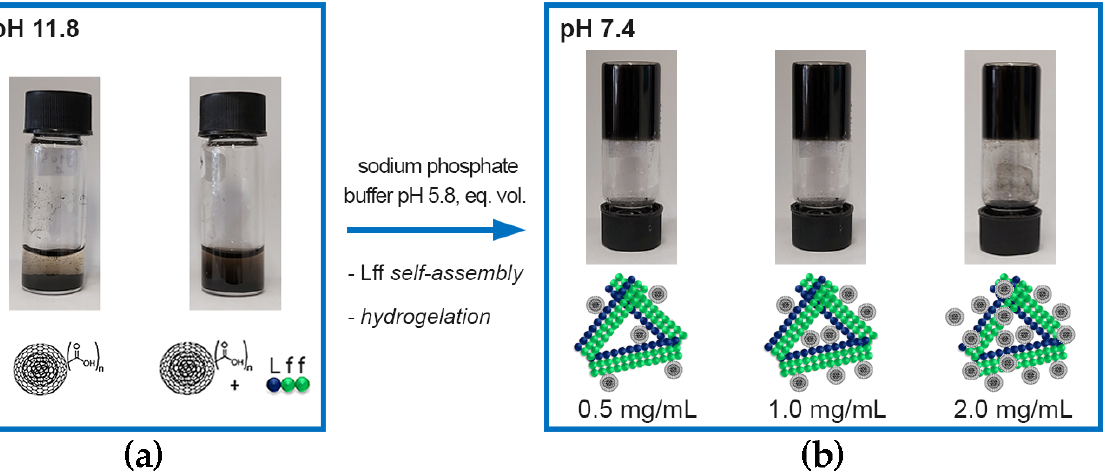
Figure 4. Photographs of ( a ) oxi-CNOs without (left) and with (right) the self-assembling tripeptide Lff in alkaline (pH 11.8) sodium phosphate precursor solution after 4 h post sonication (15 min) to prepare gels with 1.0 mg/mL oxi-CNOs, and ( b ) nanocomposite supramolecular hydrogels with 2.5 mg/mL of Lff and increasing loadings of oxi-CNOs (0.5, 1.0 and 2.0 mg/mL) at pH